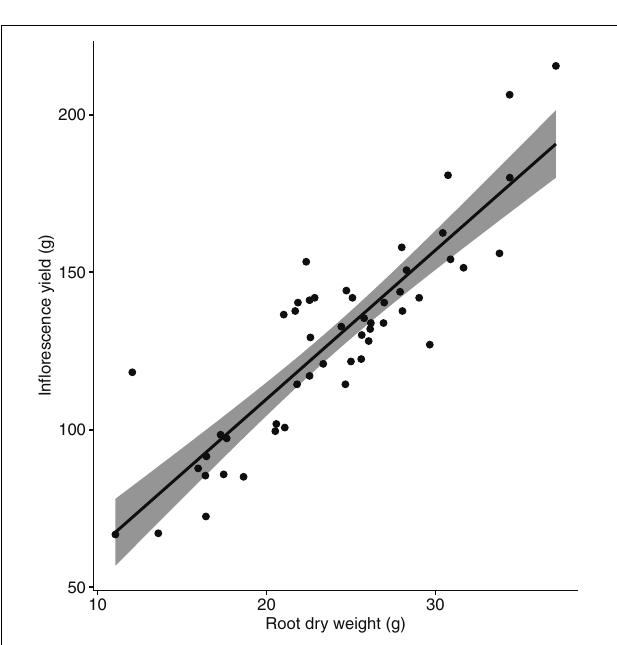
FIGURE 6 | Correlation between inflorescence yield and root dry weight of Cannabis sativa ( r = 0.9, P < 0.001). Shaded area represents 95% confidence